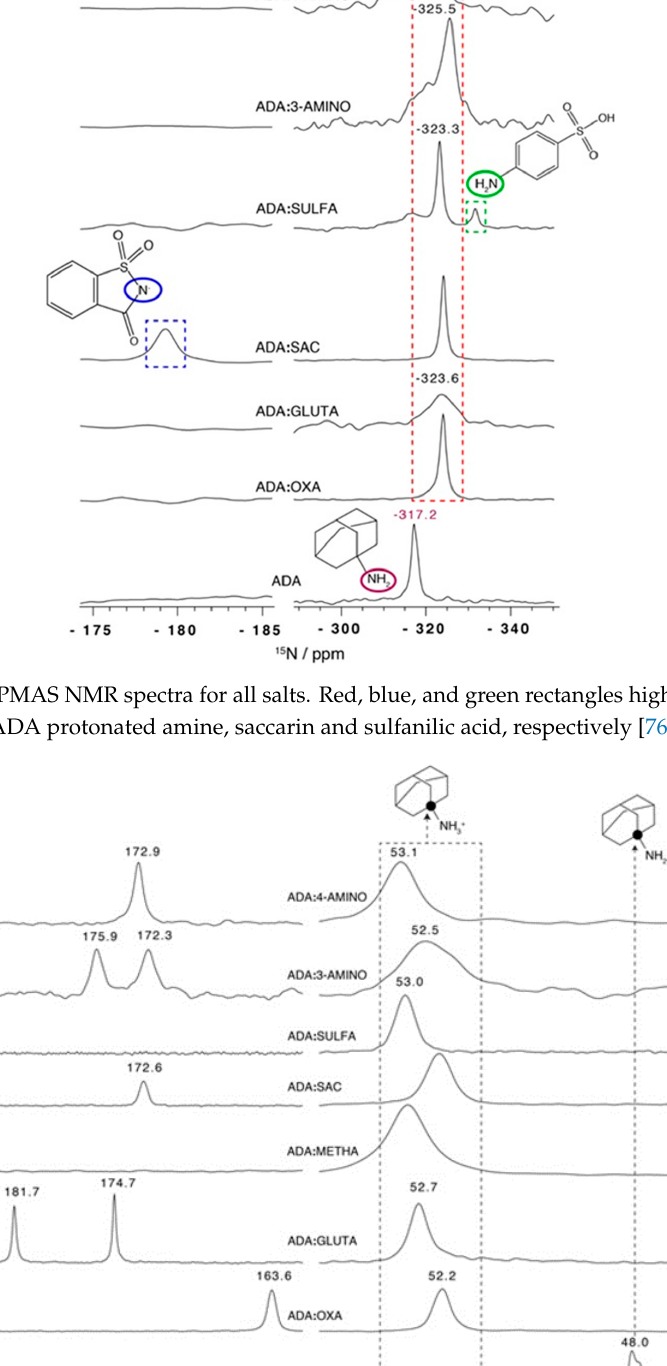
Figure 14. 13 C CPMAS NMR spectra for all salts, showing the CS range for C1 (right side) and carboxylic/carboxylate resonances (left side). Filled circles in the ADA structure indicate the position of the C1 quaternary carbon [76].